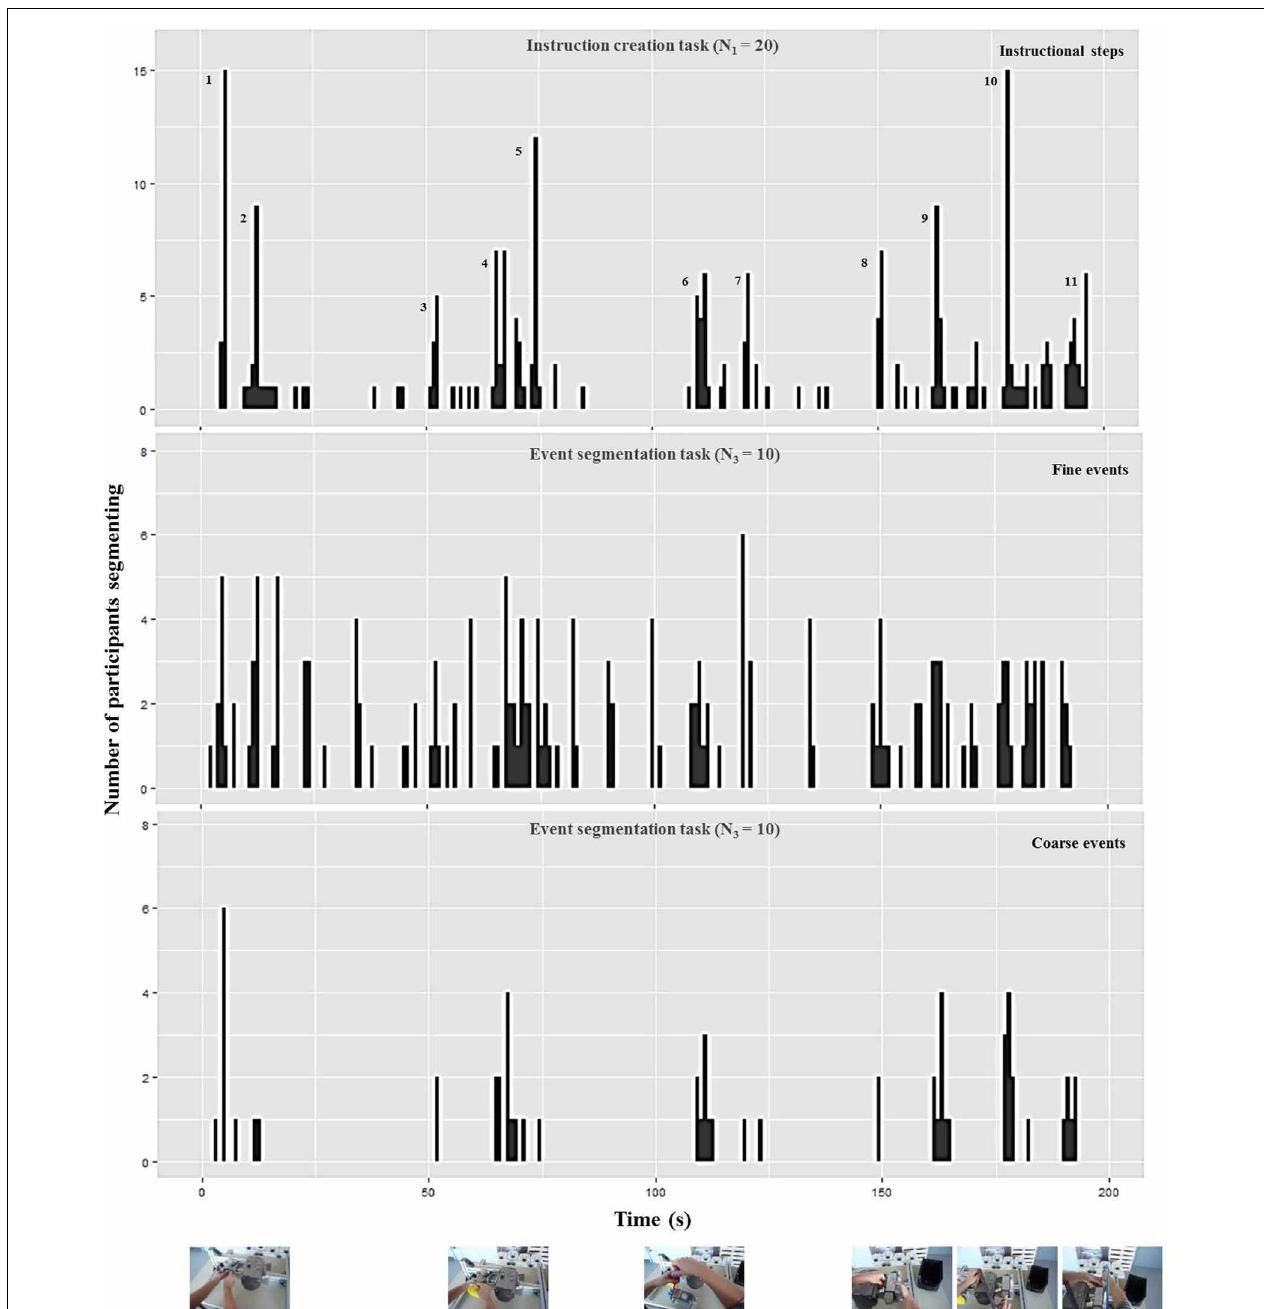
FIGURE 6 | Number of participants who identified the end point of a step (“instruction creation task,” upper diagram), a fine event boundary (“event segmentation task,” middle diagram), and a coarse event boundary (“event segmentation task,” lower diagram) during each 1-s interval of the pump scenario [adapted from Zacks et al.